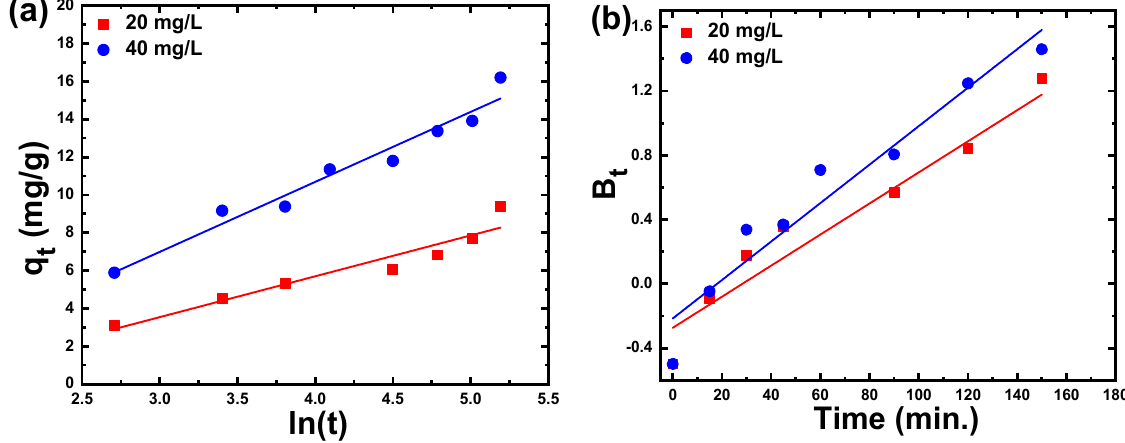
Figure 9. ( a ) Elovich kinetic model ( q t versus ln(t)) and ( b ) Boyd model ( B t versus time) for adsorption of CR dye on ZnS nanoparticles.